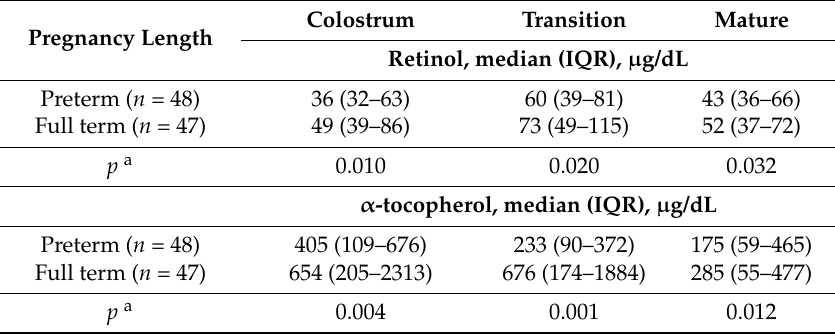
Table 4. Concentration of retinol and α -tocopherol in relation to the type of breast milk.